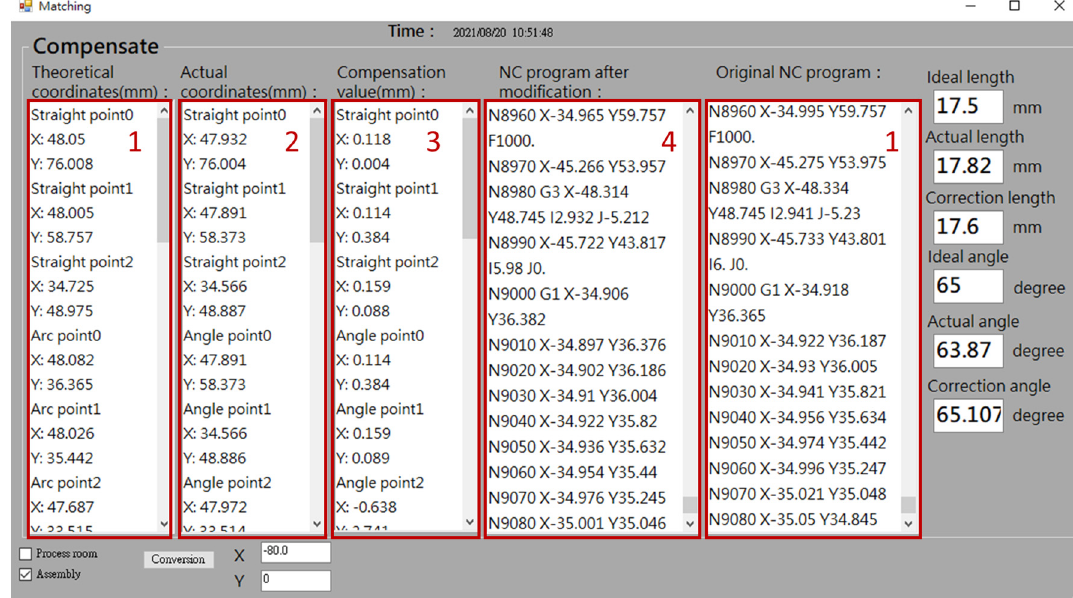
Figure 9. HMI—Error compensation interface .